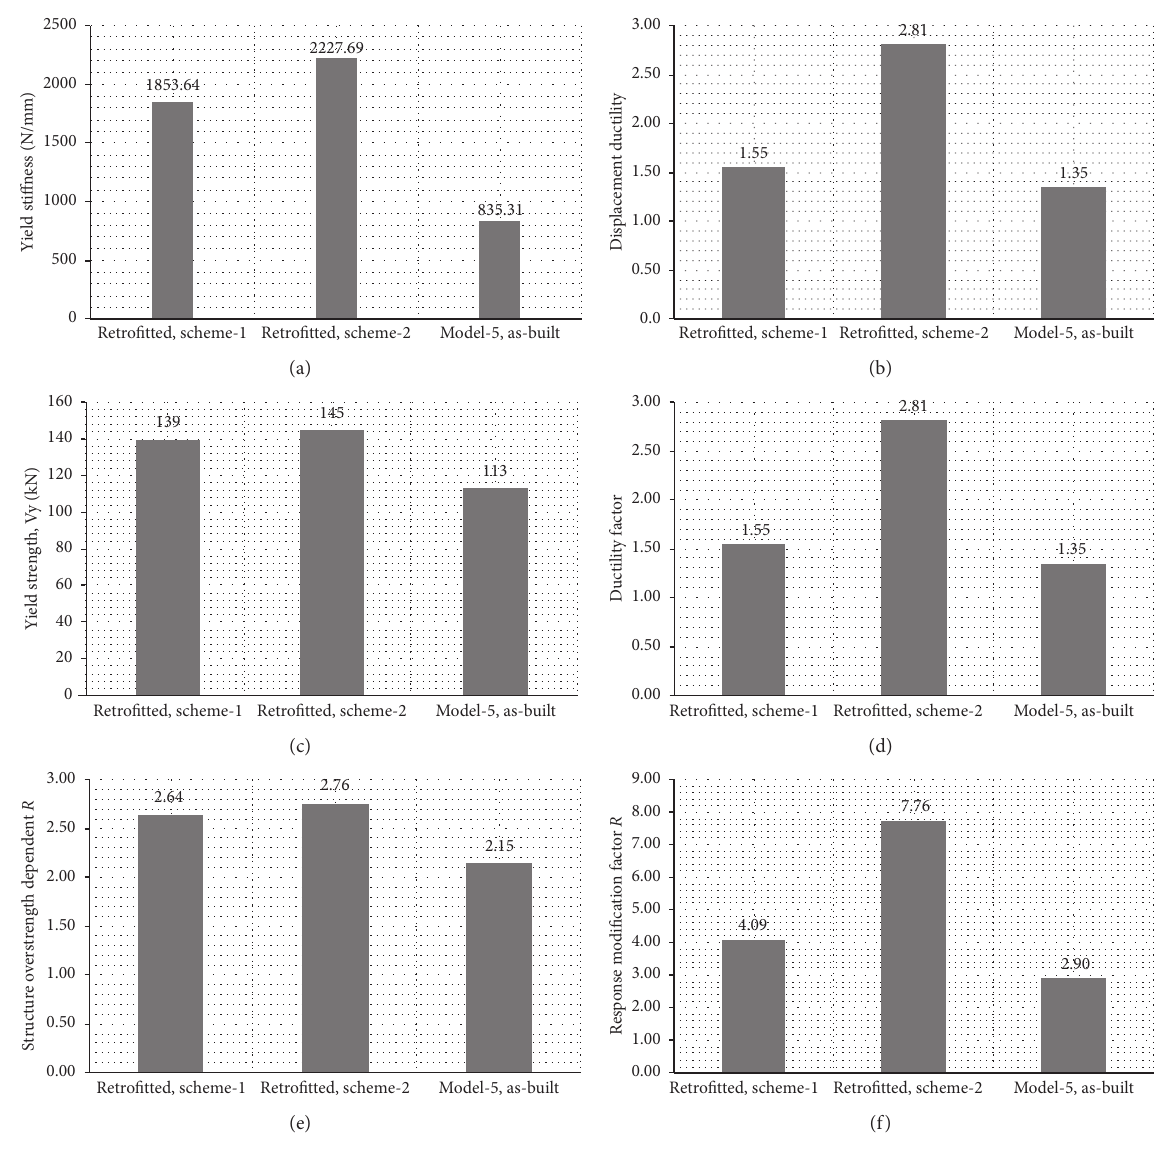
Figure 18: Seismic response parameters of as-built and strengthened RC frames obtained experimentally. (a) Yield stiffness. (b) Structure ductility. (c) Yield strength. (d) Ductility factor, Rμ . (e) Overstrength factor, Ω 0 . (f) Response modification factor, R .